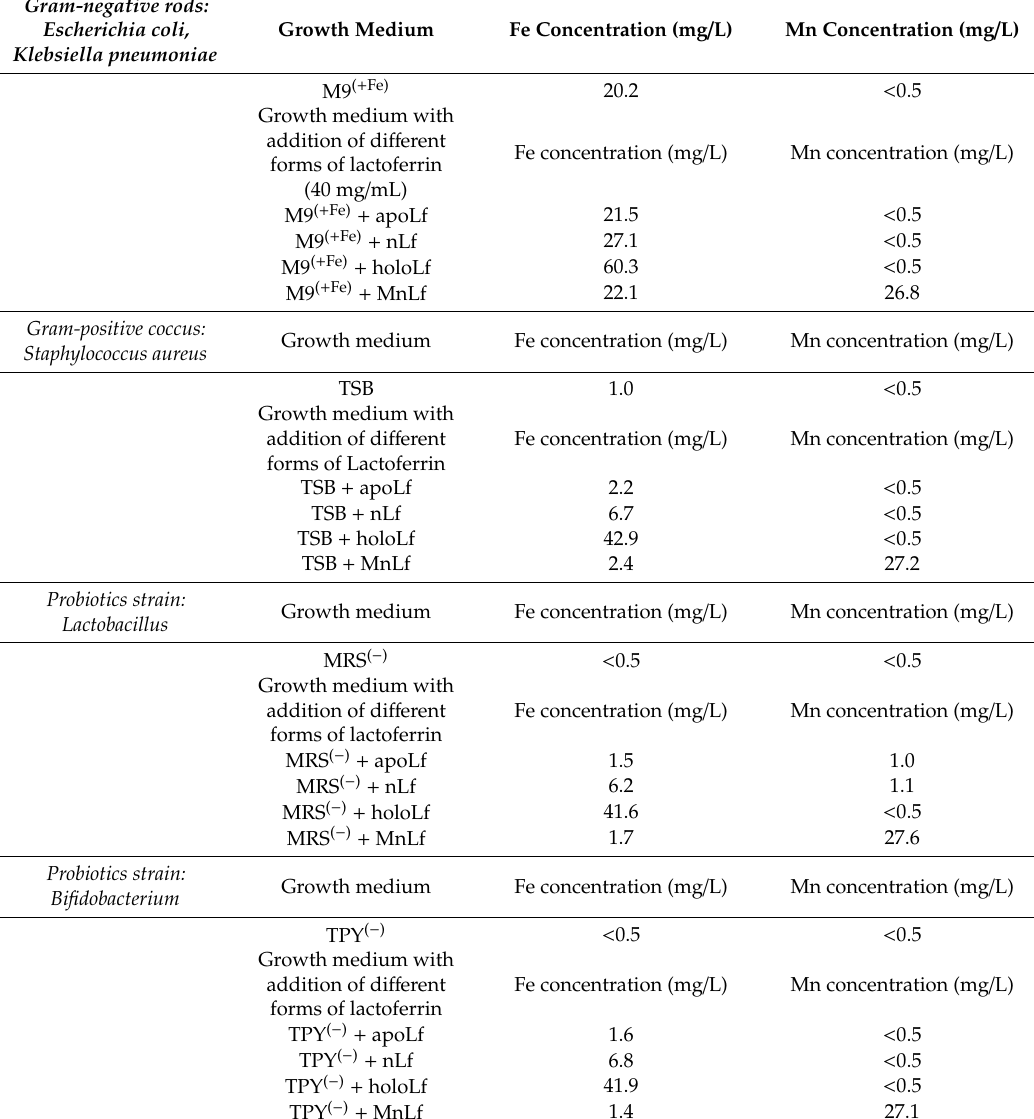
Table 1. Liquid culture media used in studies on bacterial